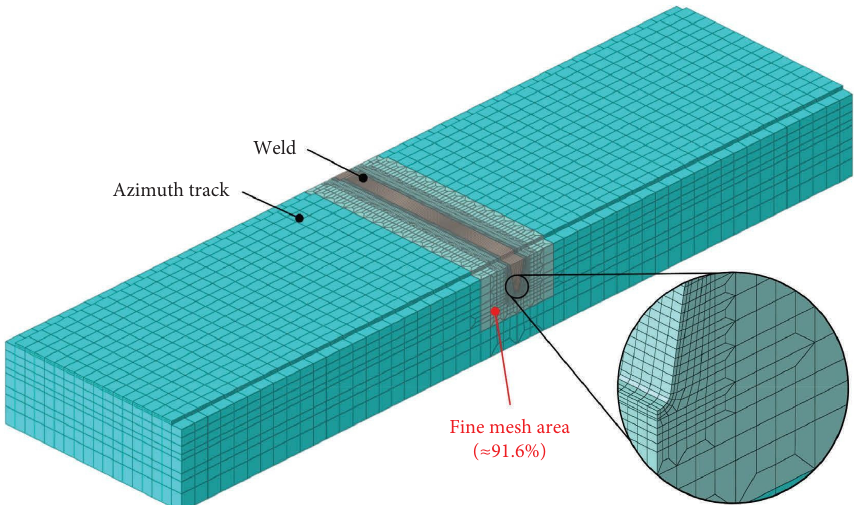
Figure 2: Meshing of the antenna’s azimuth